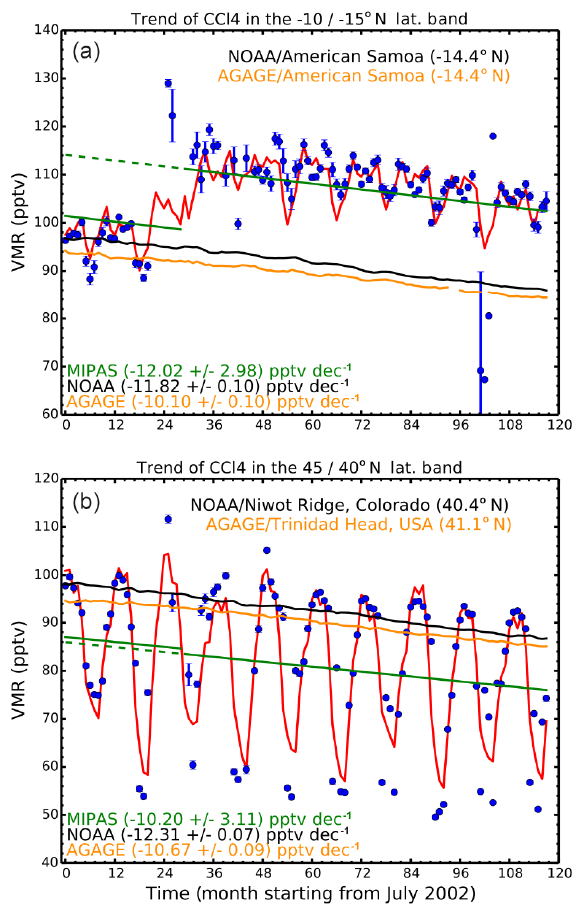
Figure 13. Comparison between MIPAS (blue dots) and NOAA/AGAGE (black/orange) CCl 4 time series. The two plots re- fer to ground stations located at tropical (a) and middle (b) latitudes. The red curve is the fitting model used to derive the trend from MI- PAS data; the green line is the linear part of the model itself. The obtained trend values are also shown in the